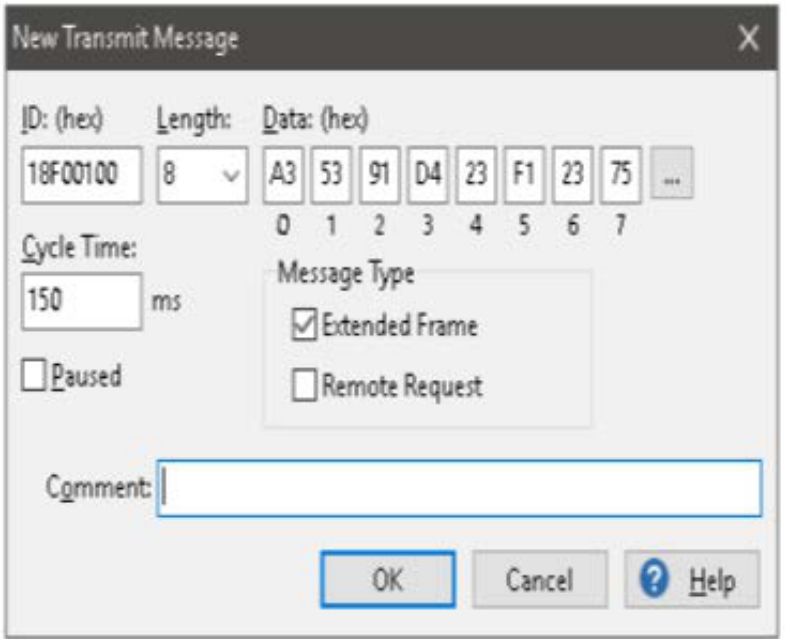
Figure 10. Communication between BMS and Charger—Dialog box new transmit message.